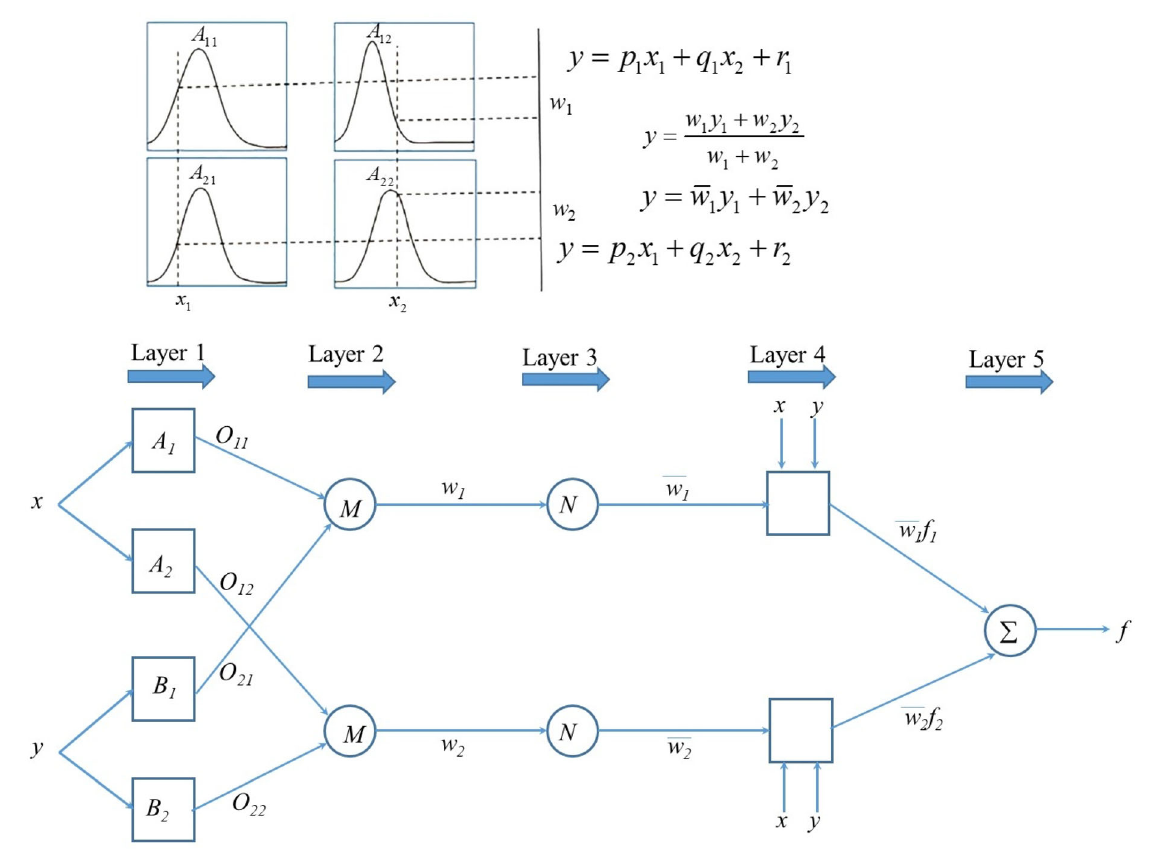
Fig. 5 A typical Sugeno fuzzy system with the corresponding ANFIS